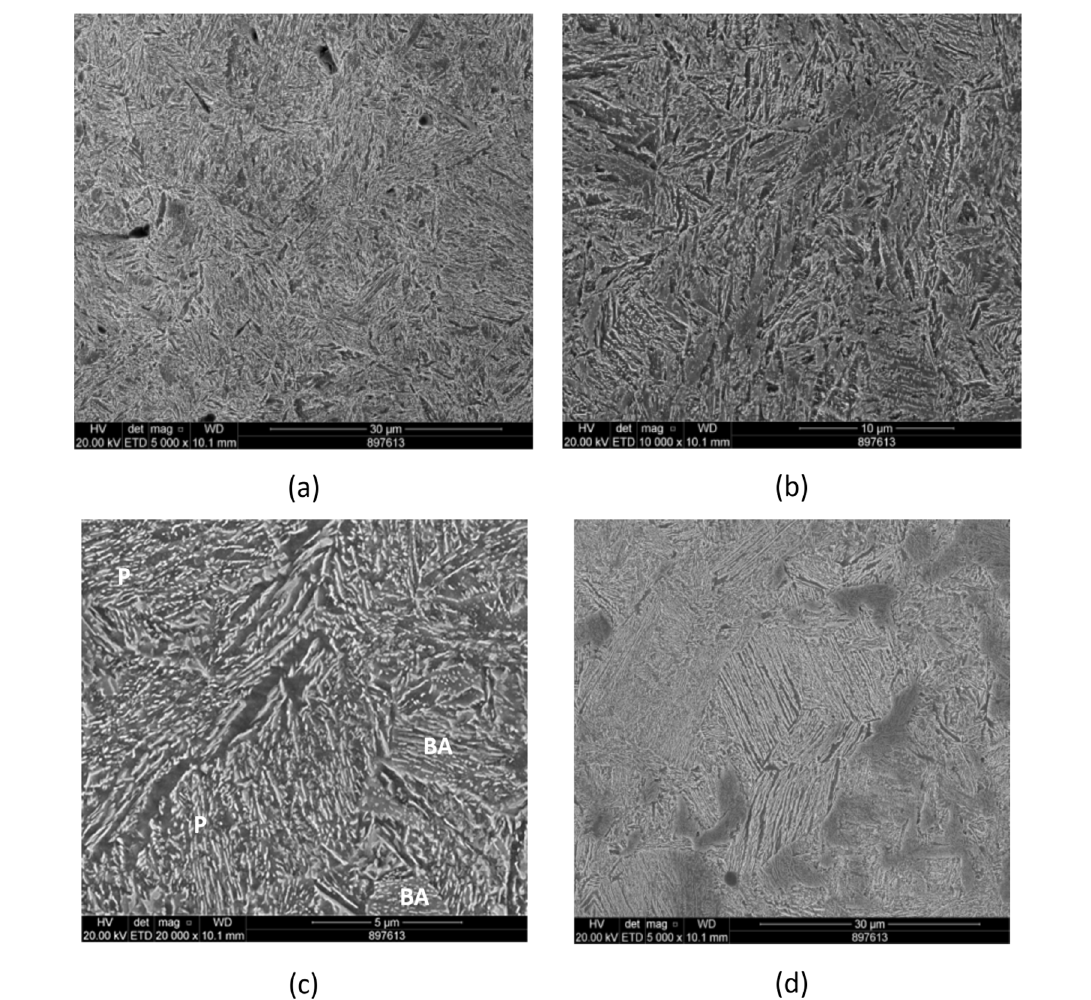
Figure 9. Microstructure of Nb steel on tread surface (a), 5 mm (b), 10 mm (c), and 15 mm (d) deep from the surface. SEM with 2% Nital. BA = Bainite and P = Pearlite.